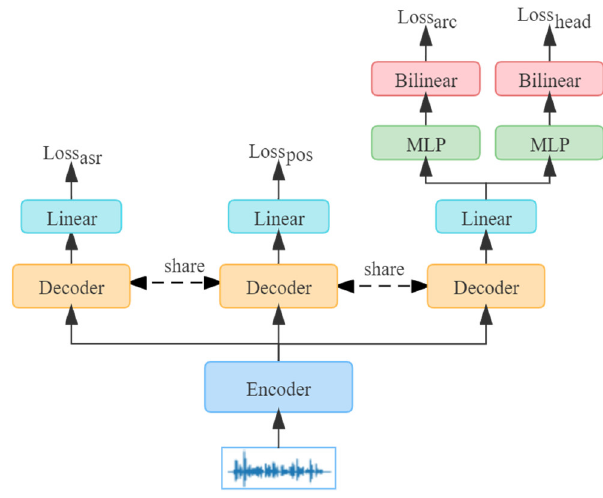
Figure 4. Multiple evaluation methodology of grammar.